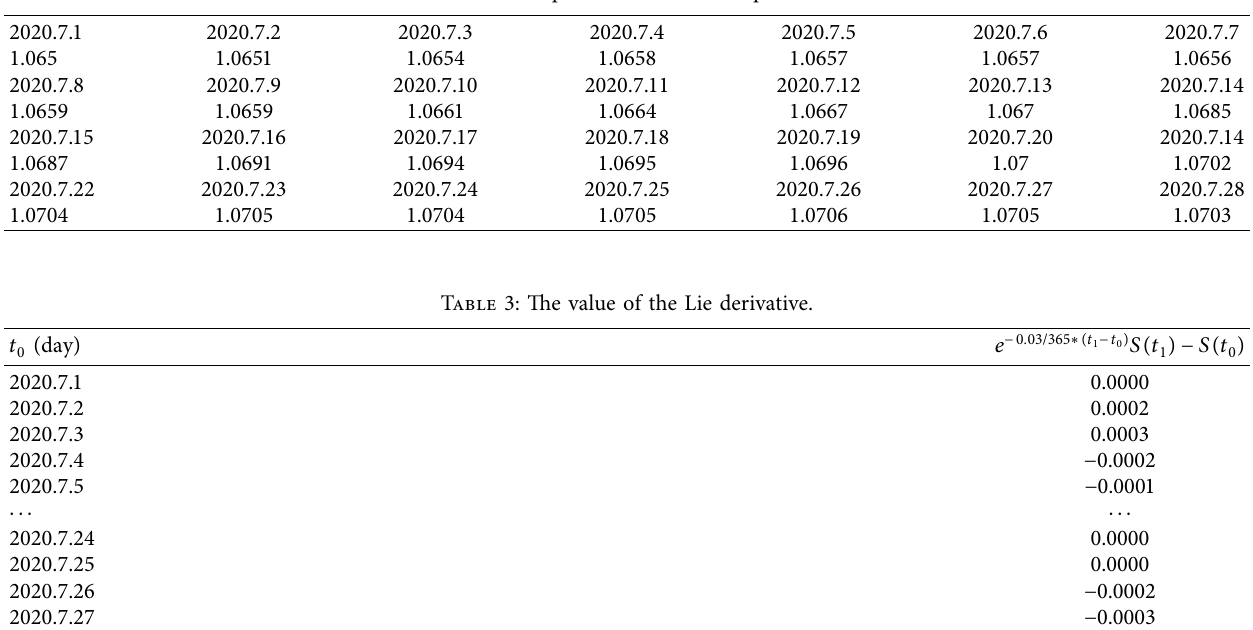
Table 2: Te prices of a net worth product.